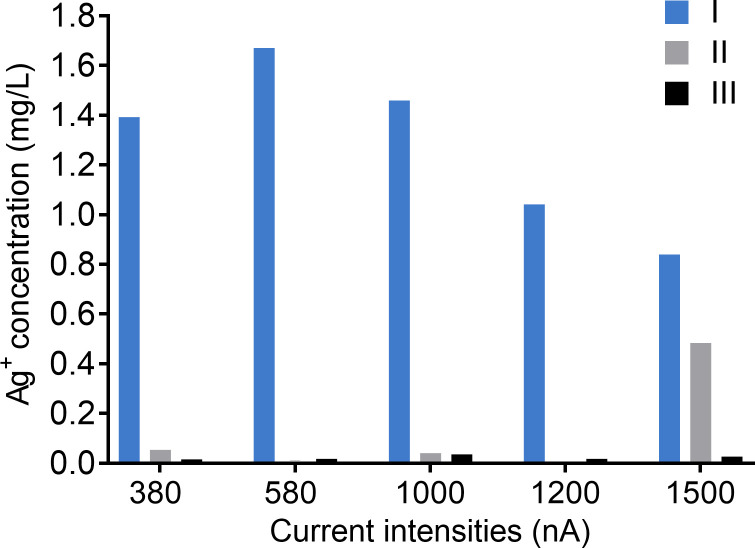
Silver ion concentrations in the cell culture medium generated by different intensities of electrical current for 21 hours.Silver ions in medium from Chamber I (blue bar), Chamber II (grey bar), and Chamber III (black bar) were measured by using inductively coupled plasma mass spectrometry (ICP-MS). The experiment was performed once.